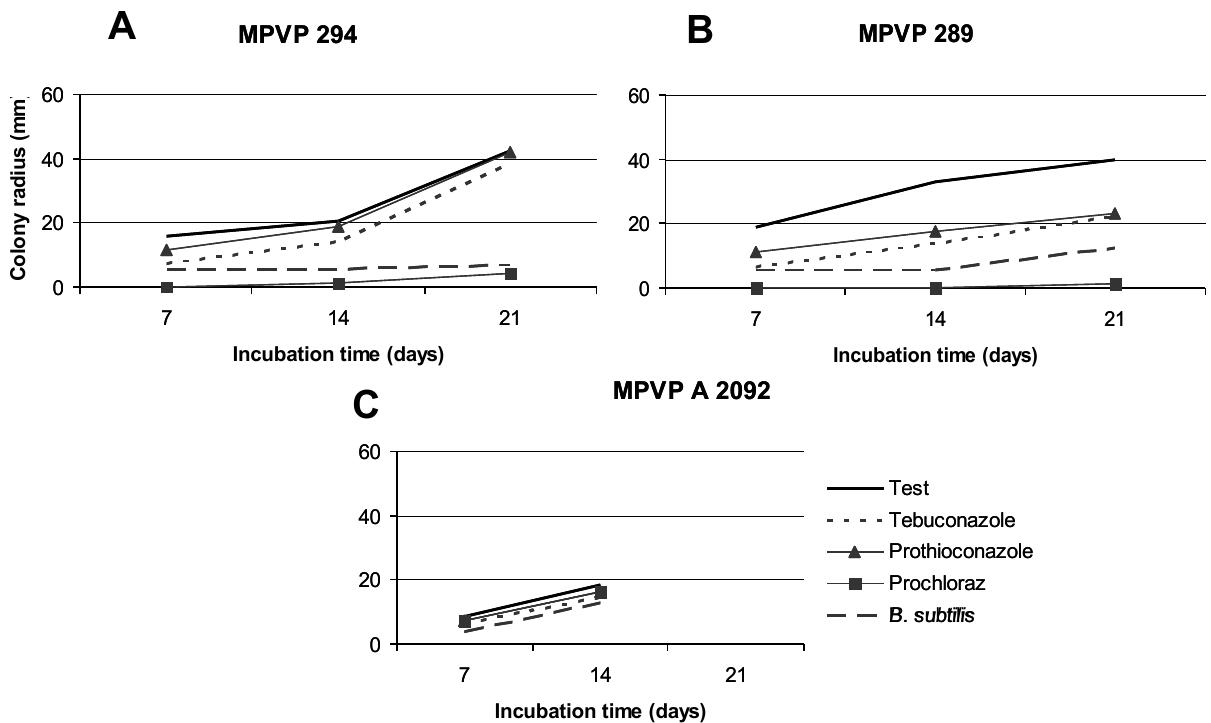
Figure 1. Effect of active ingredients (Folicur ® , Proline ® and Sportak45EW ® ) and a biocontol agent (Serenade), applied at their ED 50 , on in vitro growth of Fusarium verticillioides (MPVP 294 and MPVP 289) at 25°C after 7, 14 and 21 days of incuba - tion (A and B) and Aspergillus flavus at 25°C after 7and14 days of incubation (C), measured as colony radius